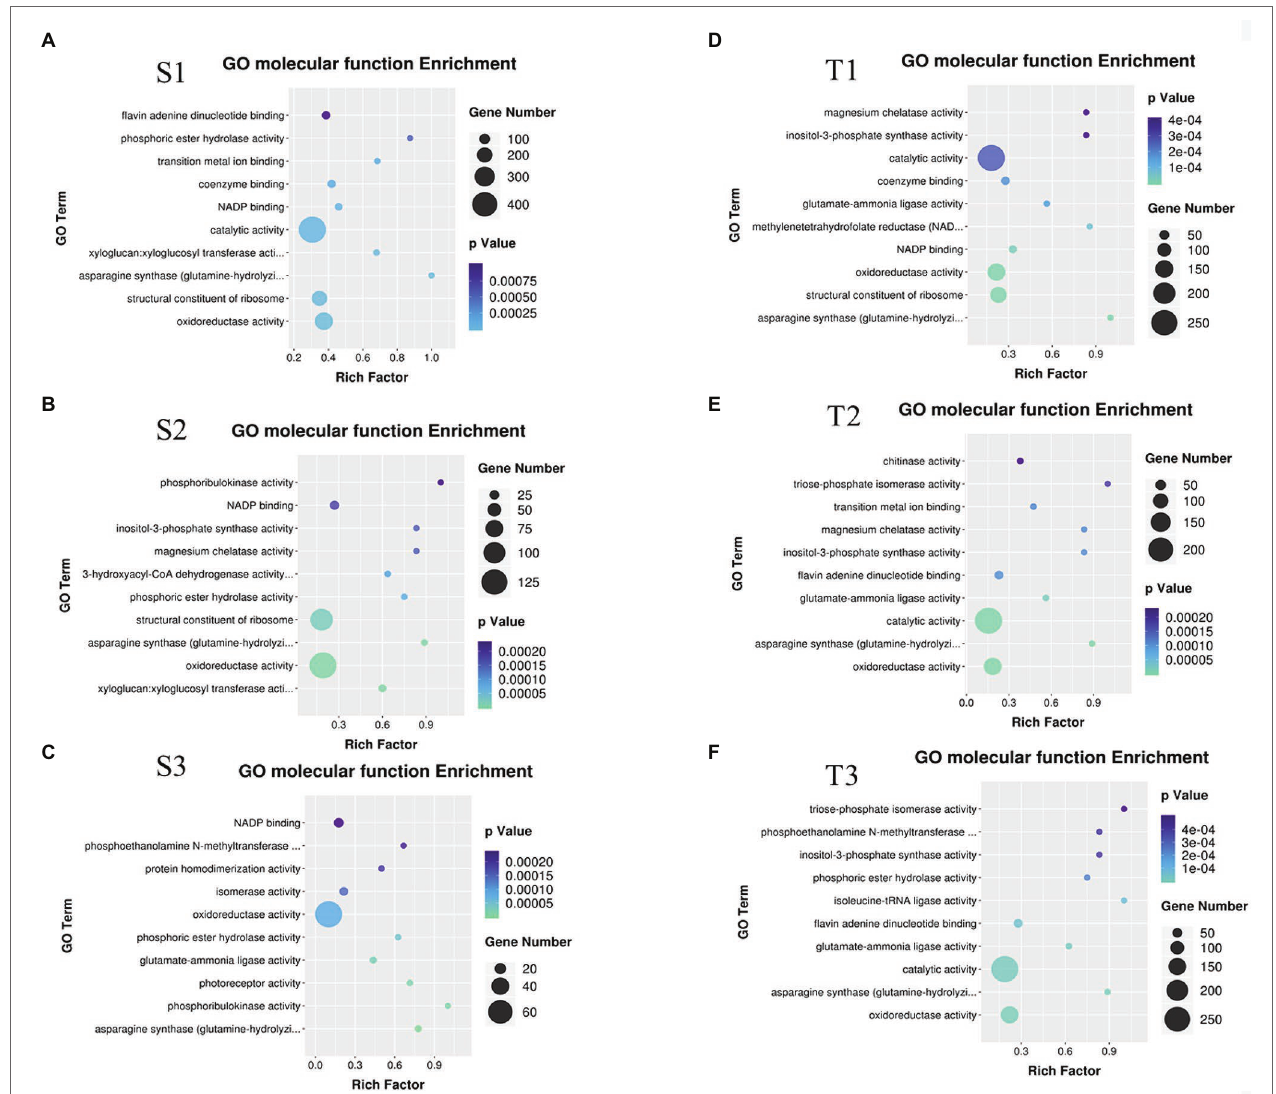
FIGURE 1 | Gene ontology (GO) molecular function enrichment analysis of DEGs. (A) GO molecular function enrichment for S1 (the sensitive variety C20 under 2 ° C compared to corresponding control); (B) GO molecular function enrichment for S2 (C20 under 0 ° C compared to corresponding control); (C) GO molecular function enrichment for S3 (C20 under − 2 ° C compared to corresponding control); (D) GO molecular function enrichment for T1 (the tolerant variety C18 under 2 ° C compared to corresponding control); (E) GO molecular function enrichment for T2 (C18 under 0 ° C compared to corresponding control); (F) GO molecular function enrichment for T3 (C18 under − 2 ° C compared to corresponding